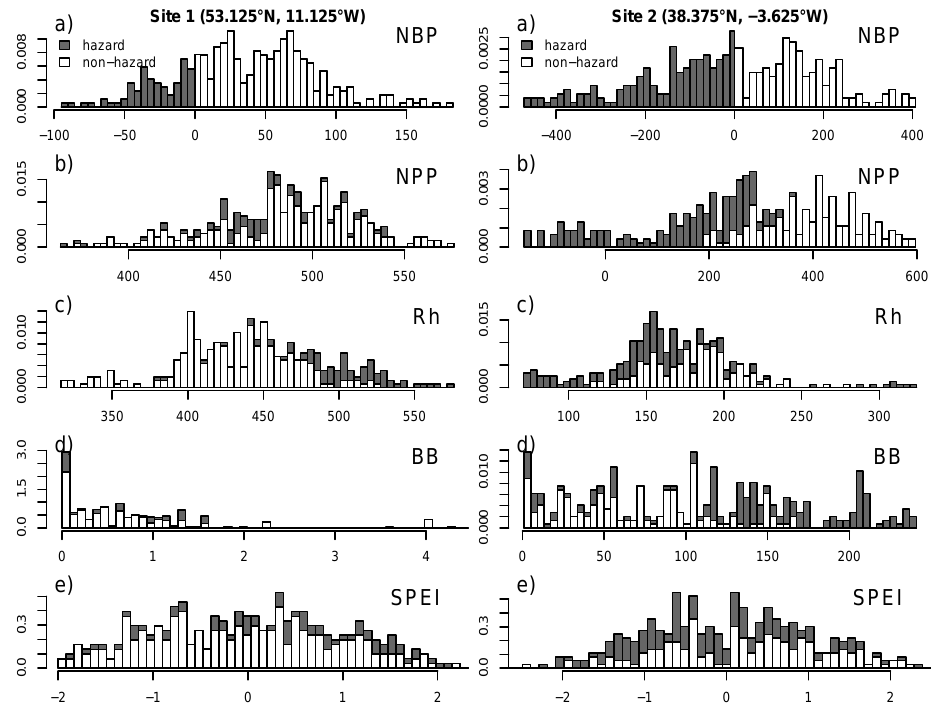
Figure 3. Probability distributions of NBP (a) and its contributions NPP (b) , Rh (c) , and BB (d) (all in gCm − 2 a − 1 ) and SPEI values (e) for Fig. 3. Probability distributions of NBP (a) and its contributions NPP (b), Rh (c), and BB (d) (all in gC m − 2 a − 1 ) and SPEI values (e) for sites 1 (left) and 2 (right) (see Fig. 2). Dark shading denotes values in the hazard group, white shading in the non-hazard group. sites 1 (left) and 2 (right) (see Fig. 2). Dark shading denotes values in the hazard group, white shading in the non-hazard group. SPEI values are significantly different ( p < 0 . 001). Here, V E (Fig. 2b) and expresses the not fully utilized vulnerability potential because such extremes occur less often. Therefore, calculated risk values cannot be related directly to the sever- ity of drought conditions, but relates ecosystem vulnerability Fig. 3. Probability distributions of NBP (a) and its contributions NPP (b), Rh (c), and BB (d) (all in gC m − 2 a − 1 ) and SPEI values (e) for to the hazard sites 1 (left) and 2 (right) (see Fig. 2). Dark shading denotes values in the hazard group, white shading in the non-hazard group.